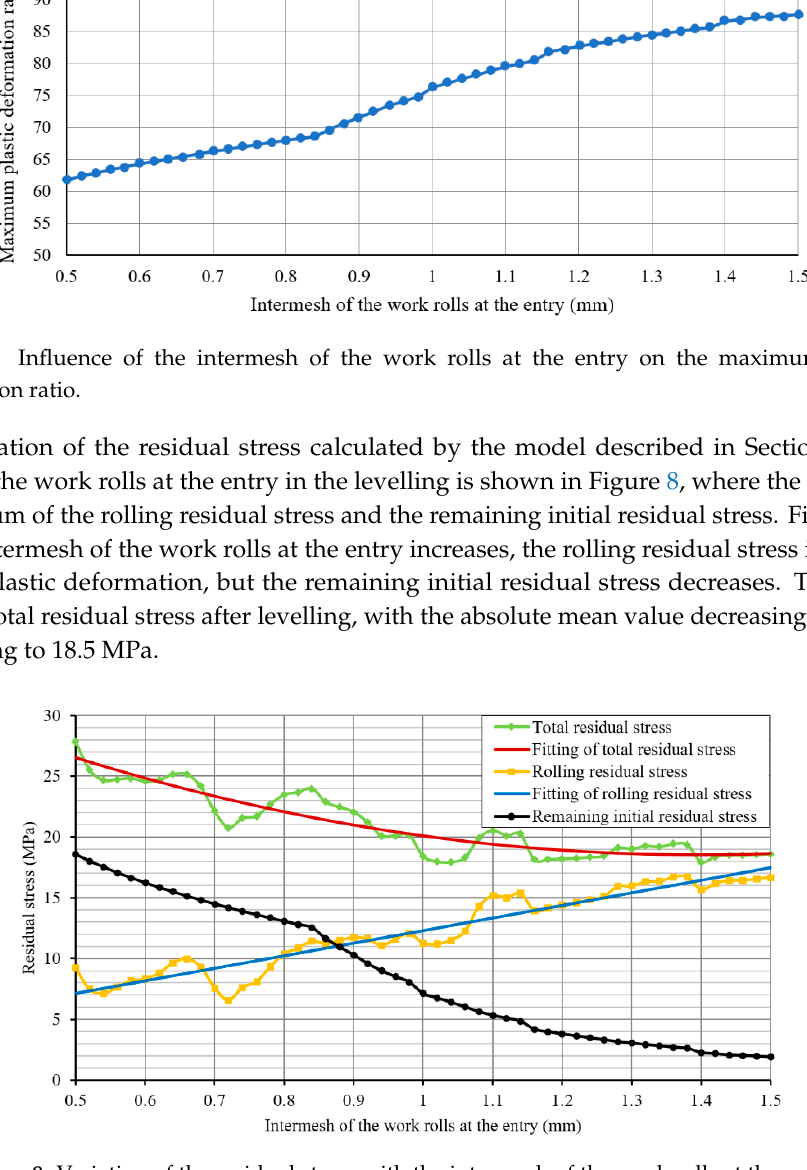
Figure 8. Variation of the residual stress with the intermesh of the work rolls at the